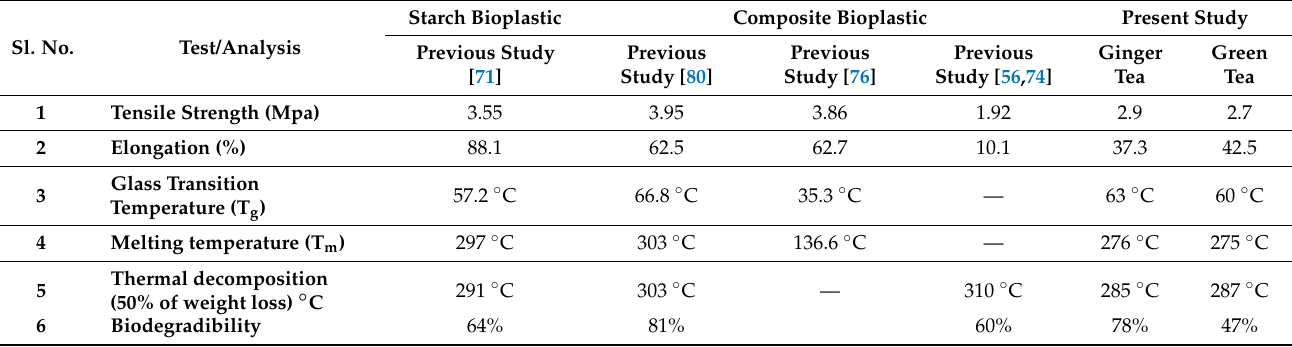
Table 7. The comparative investigation of different kinds of tea bioplastics and relative